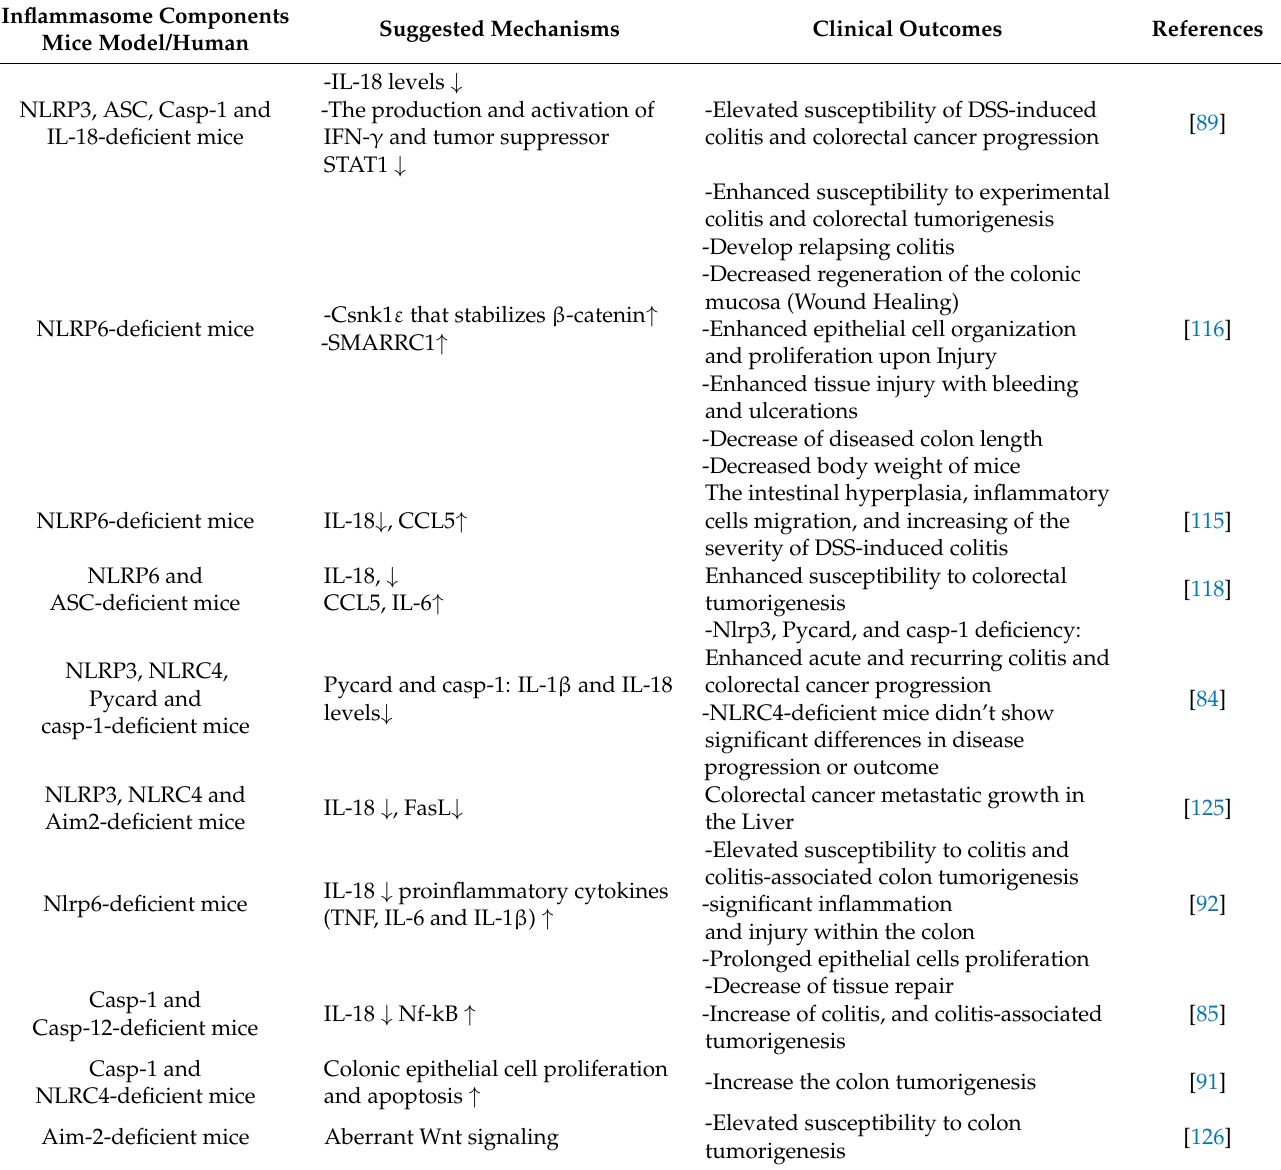
Table 1. The role of inflammasomes and their respective mechanisms in colorectal